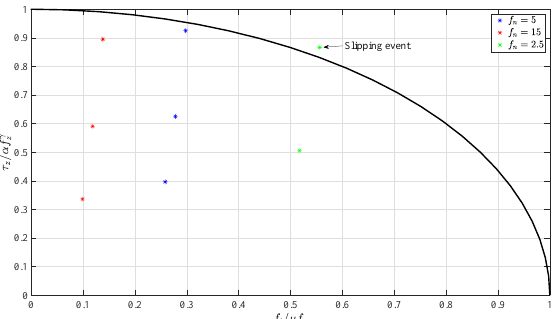
Figure 25. Fifth experiment: Tangential force and torsional moment couples with respect to the limit